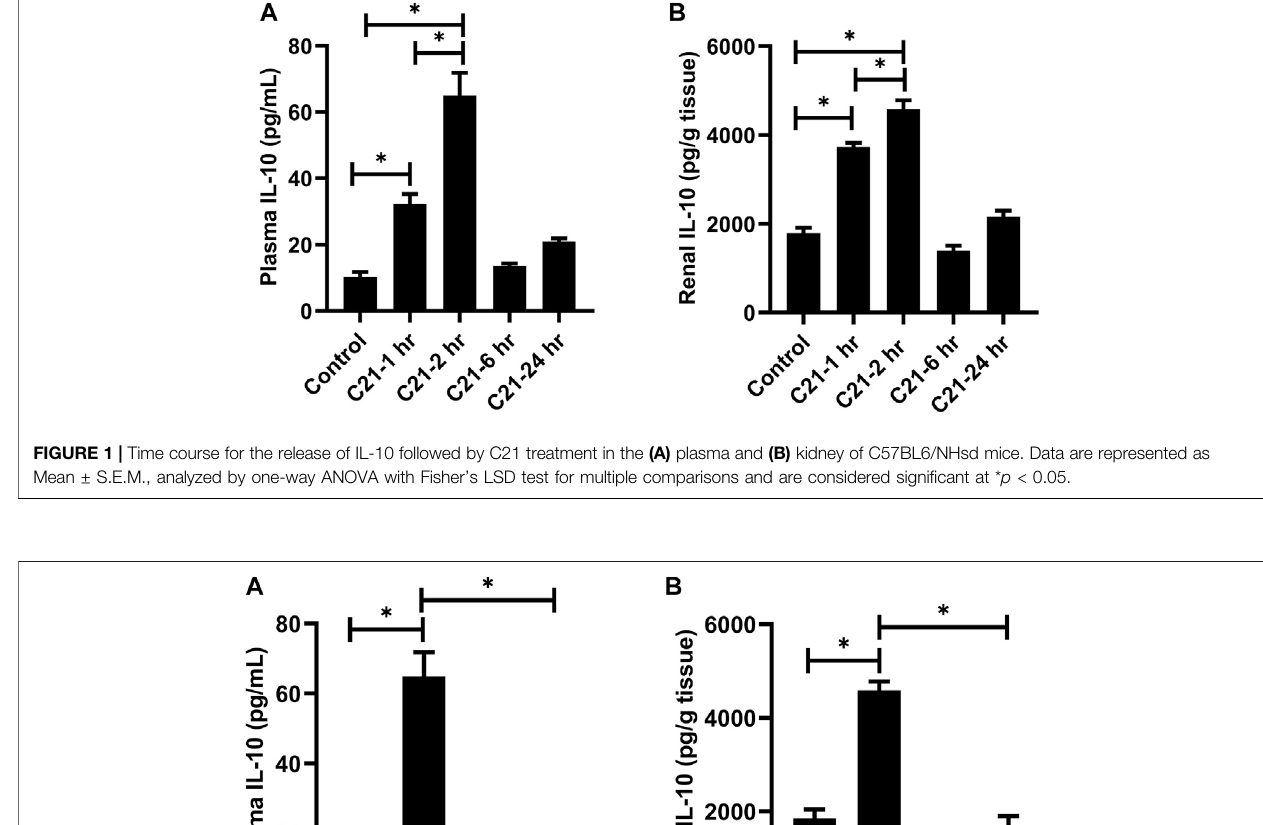
Frontiers in Pharmacology |